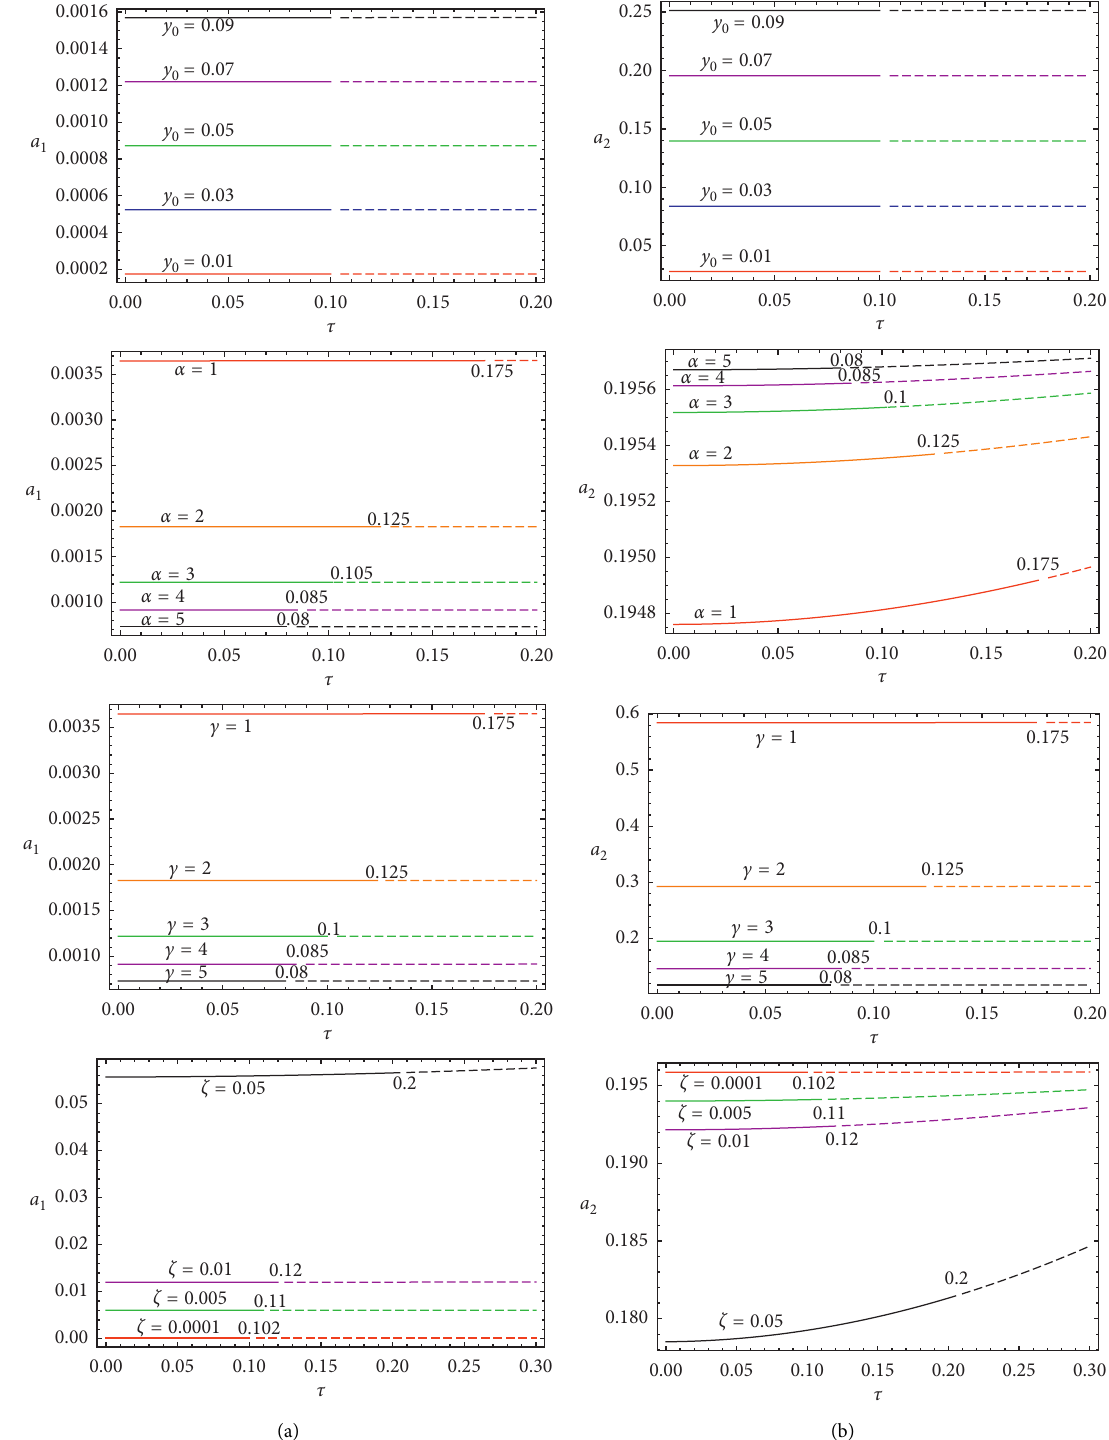
Figure 3: Time delay τ -response curves of the PPF controlled system where τ � τ